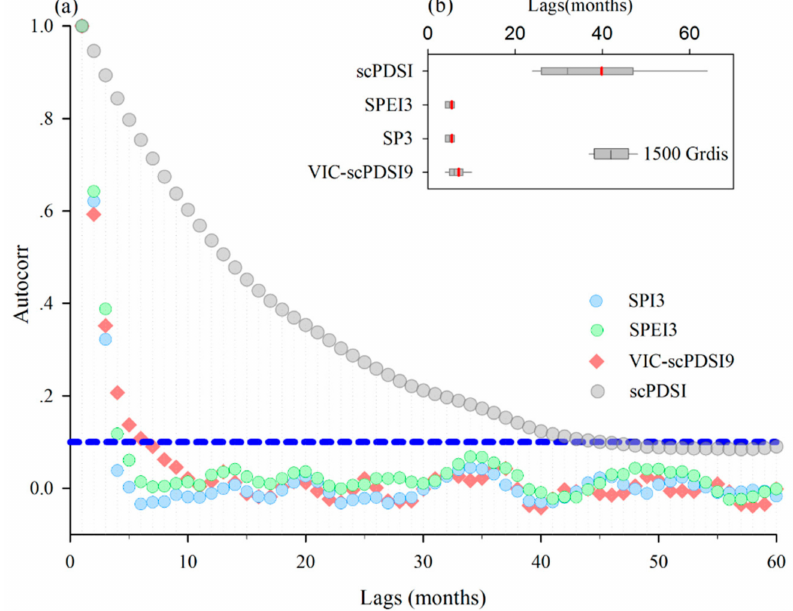
Figure 5. ( a ) Average autocorrelation coefficients of VIC-scPDSI9, SPI3, SPEI3 and scPDSI over YRB. The blue dashed line is the boundary (corresponding to the 0.05 significance level) of the presence of serial autocorrelation. ( b ) The boxplots of lagged months when the drought index series are not correlated.